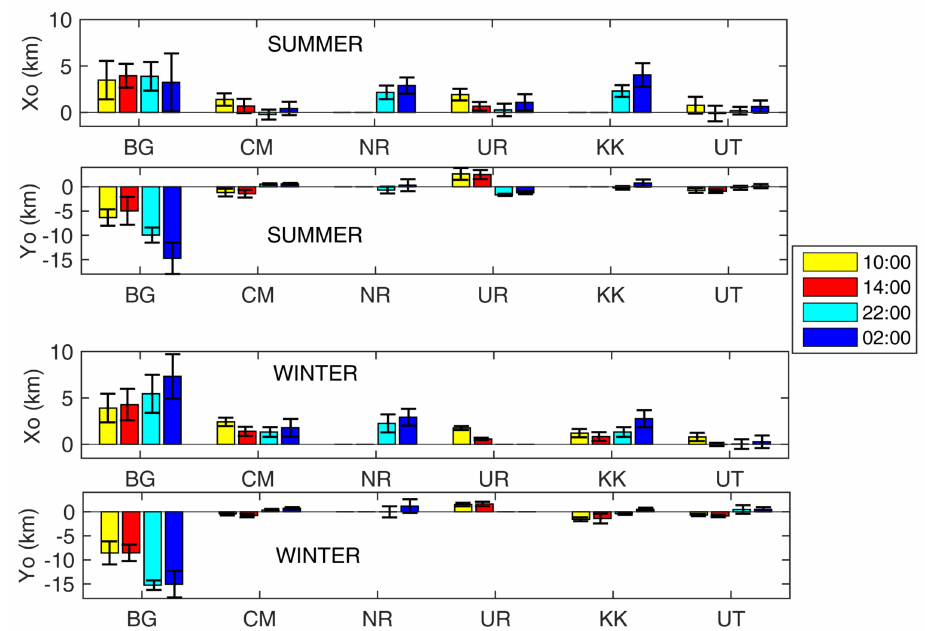
Figure 10. Intercity comparison of central location (x 0 , y 0 ) (km) during summer ( upper panels ) and winter ( bottom panels ). Central location is averaged over the 14 years, considering the diurnal variation at 10:00, 14:00, 22:00, and 02:00. The black bar is the standard deviation across the years.